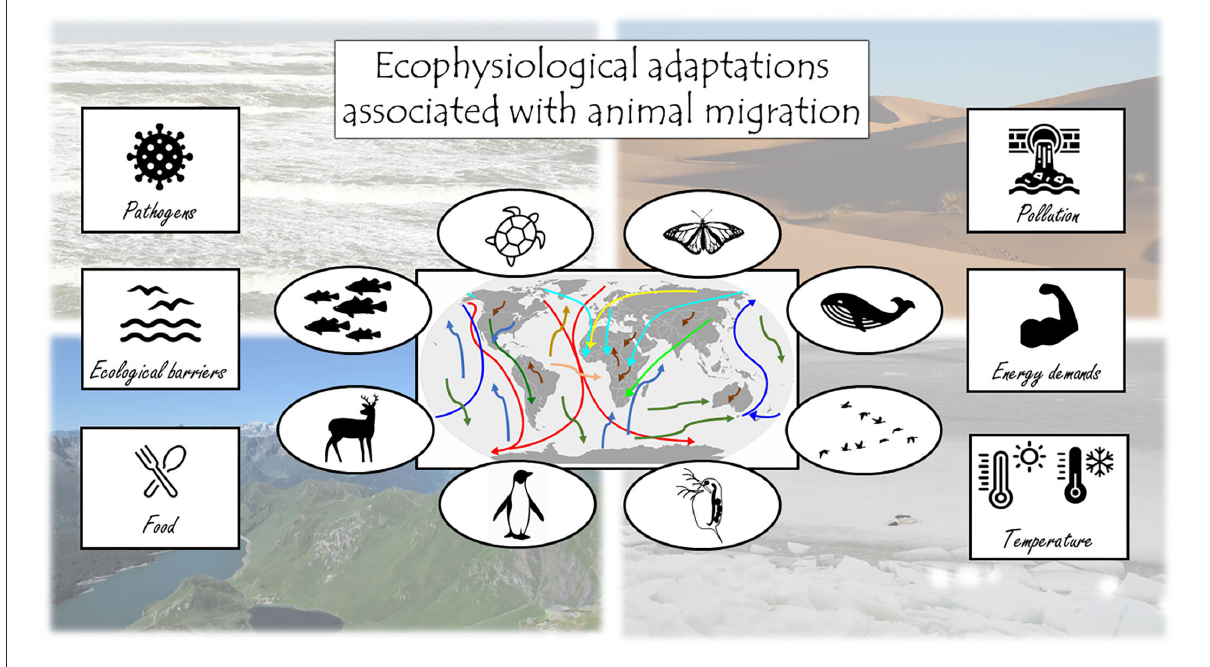
FIGURE1 Migrating animals of all taxa experience a multitude of challenges during their seasonal migrations. In this Research Topic, we collected 14 papers that investigate several of those challenges in different taxa including insects, fish, birds and